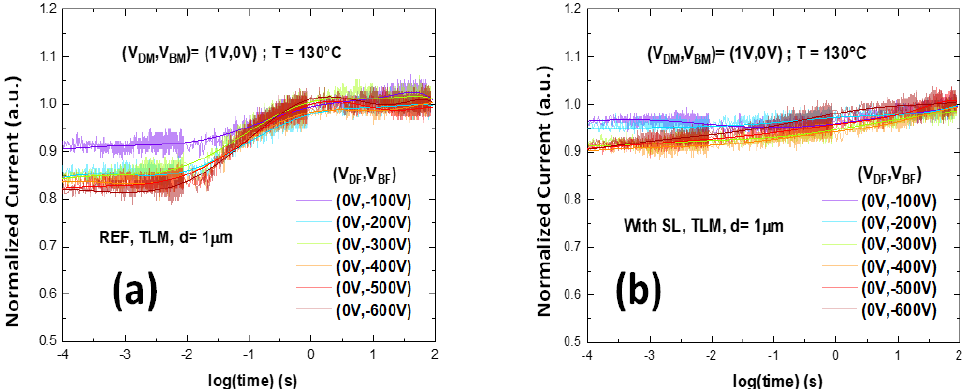
Figure 8. Back-gating transient at T = 130 °C on TLM with distance of 1 µm under six trapping conditions, ( a ) Sample A, reference device without SL, ( b ) Sample B, device with SL.